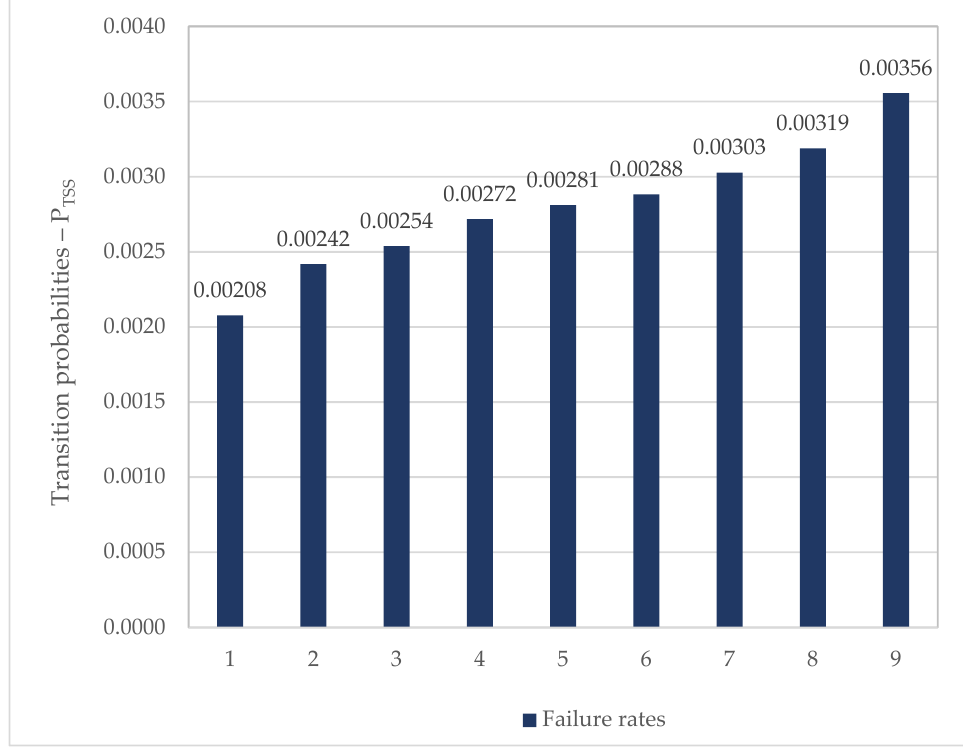
Figure 3. Dependence of the P CSS values on the failure rates λ CSS, λ TSS, and λ LSS acc. to Figure 2, for the